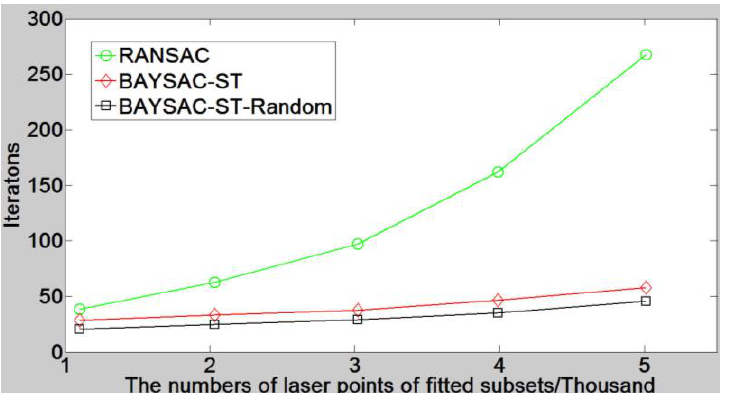
Figure 14. Computational